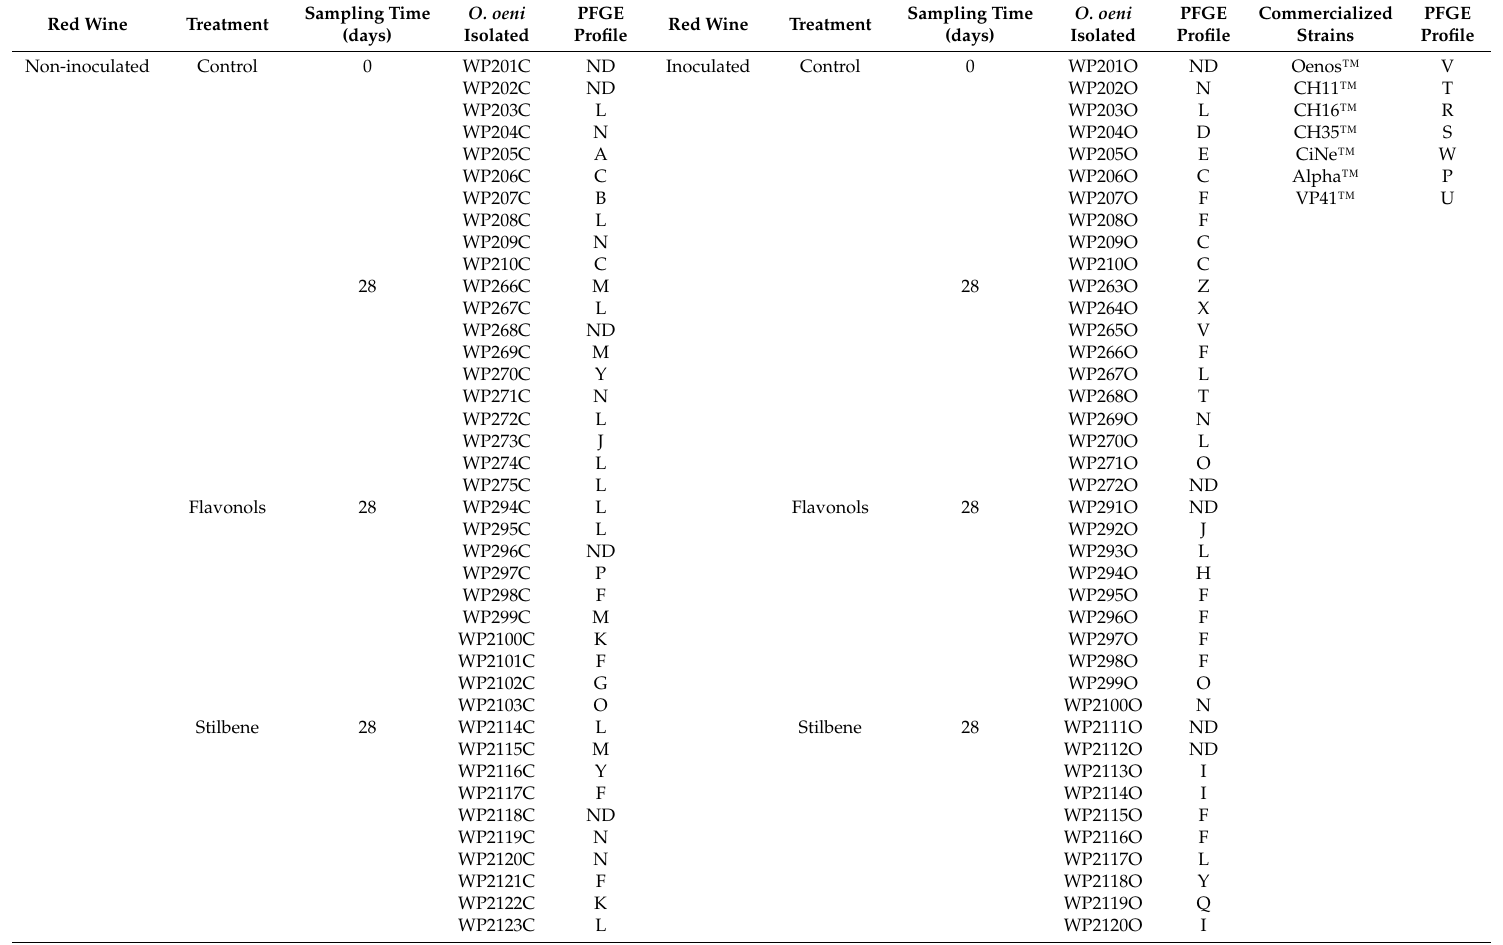
Table 3. Oenococcus oeni strains isolated from spontaneous and inoculated red wines fermented in the absence/presence of phenolic compounds: flavonols and trans